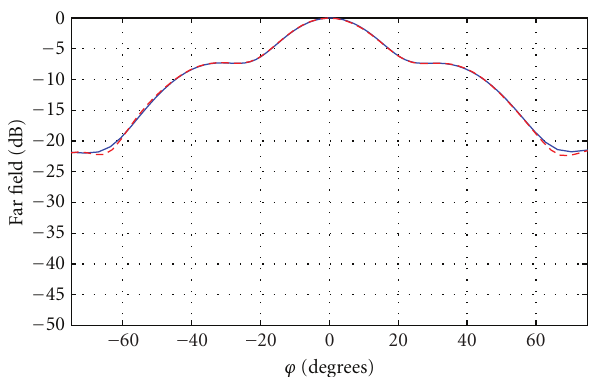
Figure 14: Dual horn, horizontal polarization, sum pattern. ϕ cut of the ϕ component of the far field. Blue solid line: proposed approach. Red dashed line: approach in [7, 8].